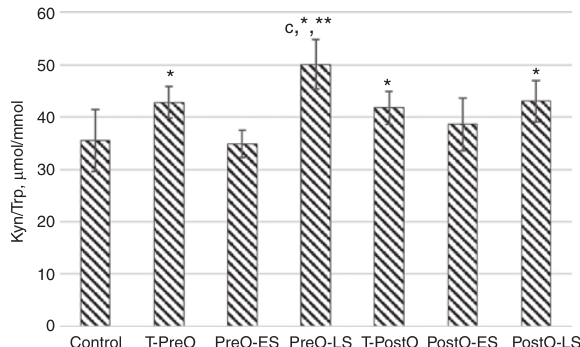
Figure 2: Alterations in the kynurenine/tryptophan levels of the control and larynx cancer patient groups. T, Total larynx cancer patients group; PreO, pre-operative; PostO, post-operative; ES, early stage larynx cancer; LS, late stage larynx cancer; c p < 0.01, Spearman correlation, PreO-LS neopterin – PreO-LS Kyn/Trp; *p < 0.01, control vs. patient group; **p < 0.01, ES vs. LS patient